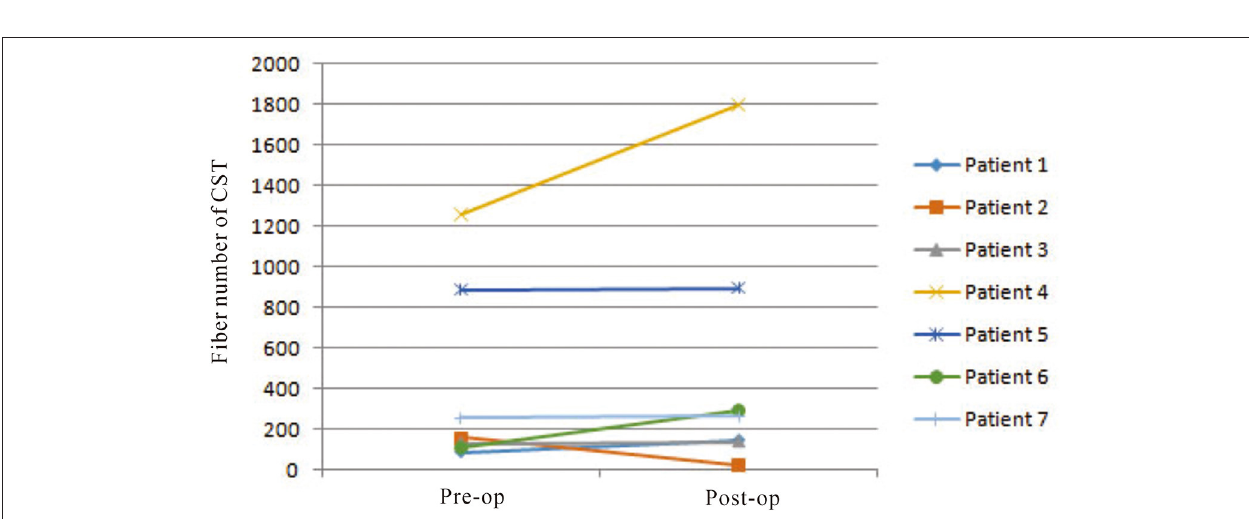
FIGURE 5 | The change of mean FA values of ipsilateral CSTs on pre- and postoperative DTI images was not significant ( p = 0.289).